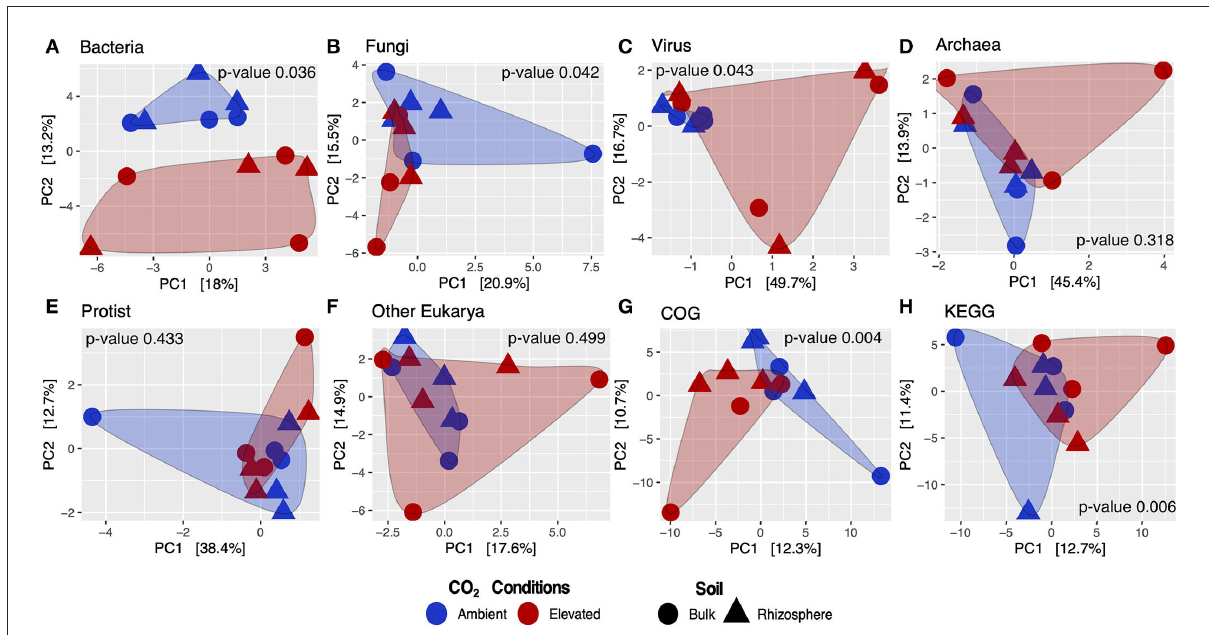
FIGURE1 Beta diversity analysis of core microbial taxa and transcripts from the Gi-FACE metatranscriptome. Principal components analysis (PCA) of (A) bacteria, (B) fungi, (C) virus, (D) archaea, (E) protist, (F) other eukarya, (G) GenBank COG, and (H) KEGG functions; p-values from PERMANOVA